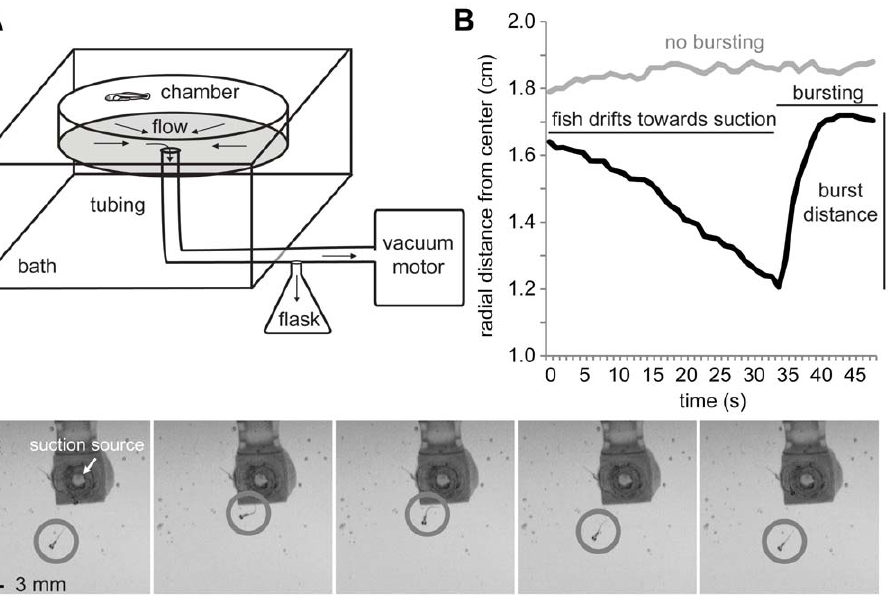
Figure 1. Larvae burst away from a continuous suction source at 5 days post fertilization. A. Schematic of the experimental suction chamber which is immersed in a large volume bath and connected with tubing to a retention flask and vacuum motor. B. Comparison of two suction avoidance behaviors. Position of a larva (black line) drifting towards and then bursting away from the suction source (origin at 0 cm), and another larva continuously holding station instead of bursting (gray line). C. Time series of a rheotactic larva (gray circles) escaping the suction source (arrow) with a quick burst of swimming. Frames taken every 350 ms.